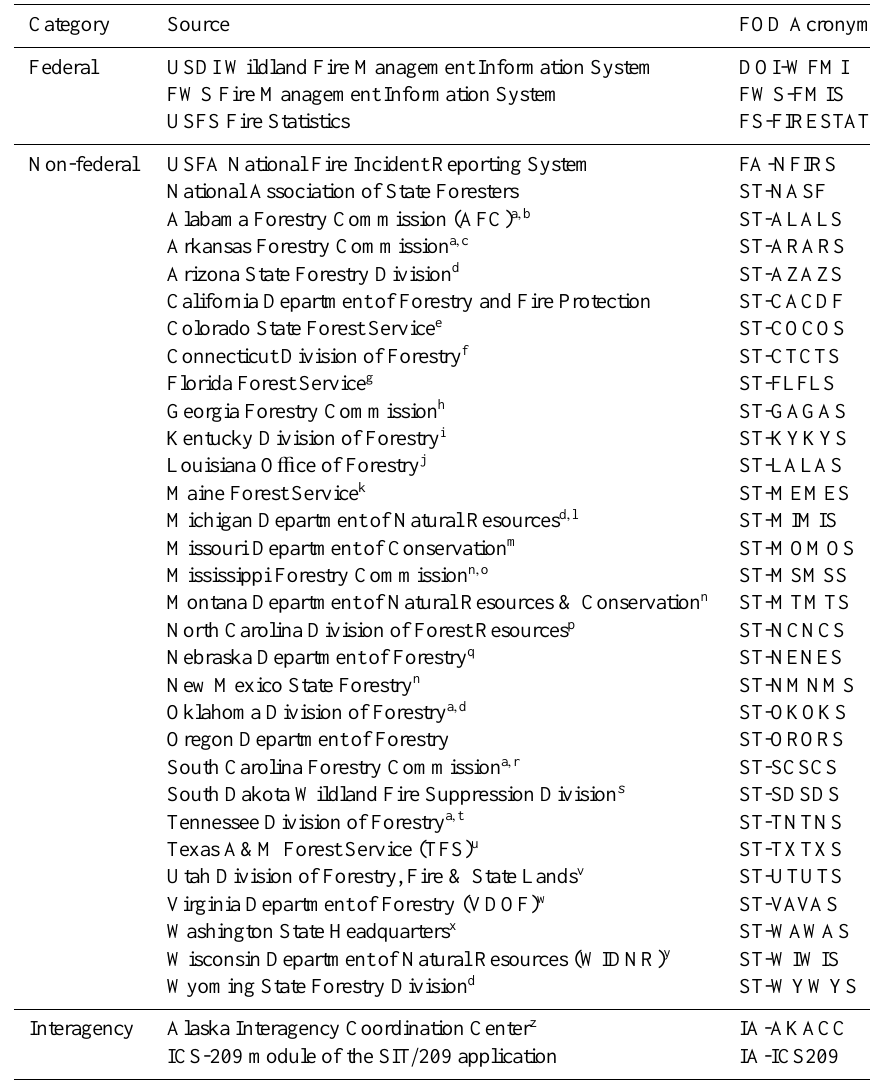
Table 1. Sources of wildfire data in the FPA FOD. Although the National Fire Incident Reporting System is administered by a federal agency (USFA), we refer to it as a non-federal system, because it includes fire reports from local departments rather than from federal agencies. We distinguish the Alaska Interagency Coordination Center and ICS-209 as interagency systems, because they are sources of federal, state, and local